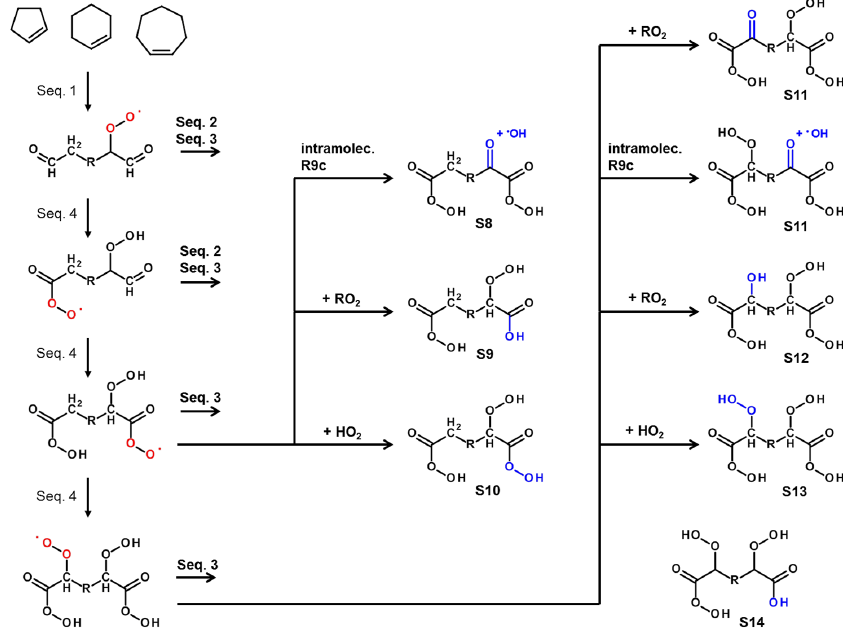
Figure 4. Examplaric mechanistic scheme in accordance with the results of the ozonolysis of cycloalkenes. Cyclopentene: R = (CH 2 ) , cyclohexene: R = (CH 2 ) 2 , cycloheptene: R = (CH 2 ) 3 . The peroxy radicals with increasing number of O atoms ( m/z = m ) on the left-hand side are formed by autoxidation (Sequence 4). They can undergo either termination reactions in Sequence 2 or follow the hydroxy–peroxy path (Sequence 3). The carbonyl ( m − 17), hydroxy ( m − 15) and hydroperoxy ( m + 1) termination products are shown for the O 8 –peroxy radical (S8–S10) and the O 10 –peroxy radical (S11–S12) in the middle and right hand column, respectively. The functional groups formed by the termination reactions are shown in blue. The products S8 and S11 from the intramolecular termination (Reaction R9c) are the same as for the intermolecular termination Reactions (R5a) and (R6b). Note that in principle, the series of rearrangements can be also permuted. If the H atoms at the C atom in α -position to the second aldehyde group are subject to H shift before attack on the aldehyde group itself, structures like S14 could be formed, isobaric to